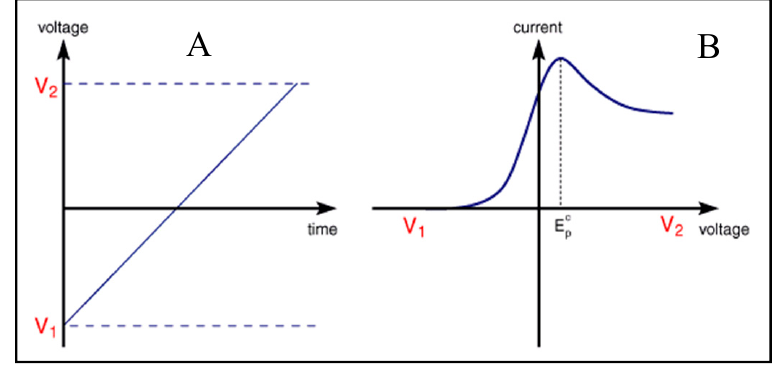
Figure 7. Linear sweep voltammetry showing ( A ) potential scan with time and ( B ) the voltammogram (Adapted from [109]).